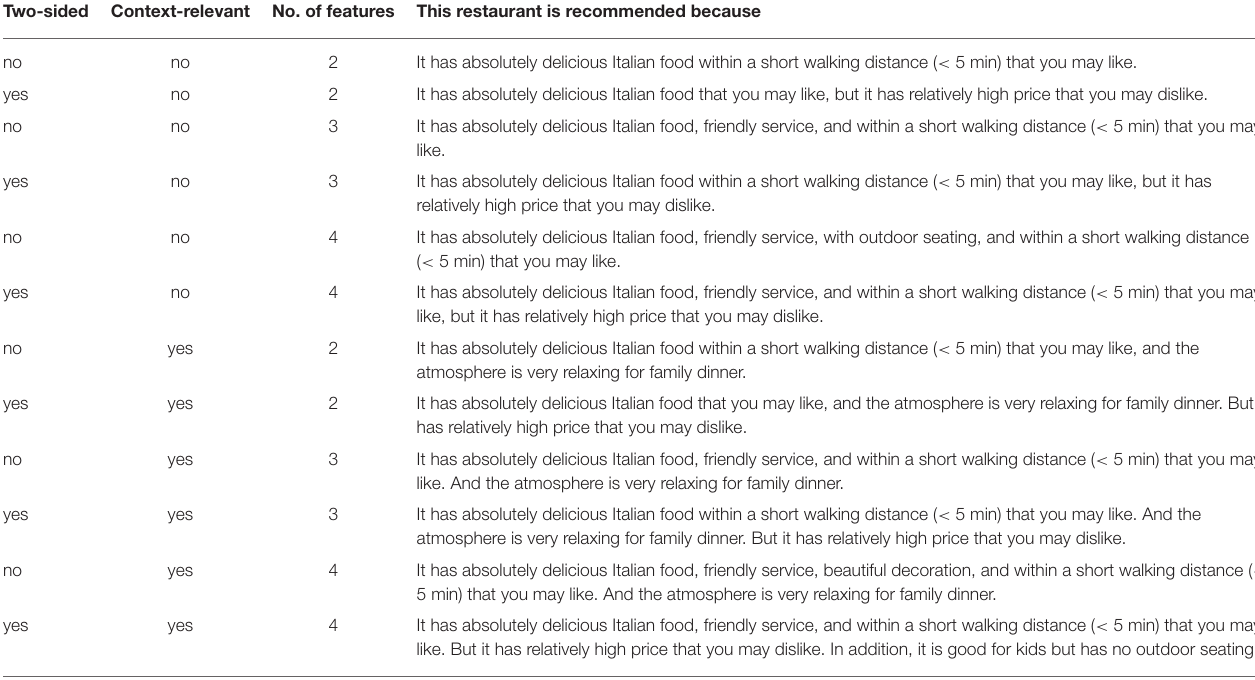
TABLE 2 | (Pilot study) 12 feature-based explanations associated to the same restaurant. Two-sided Context-relevant No. of features This restaurant is recommended because no